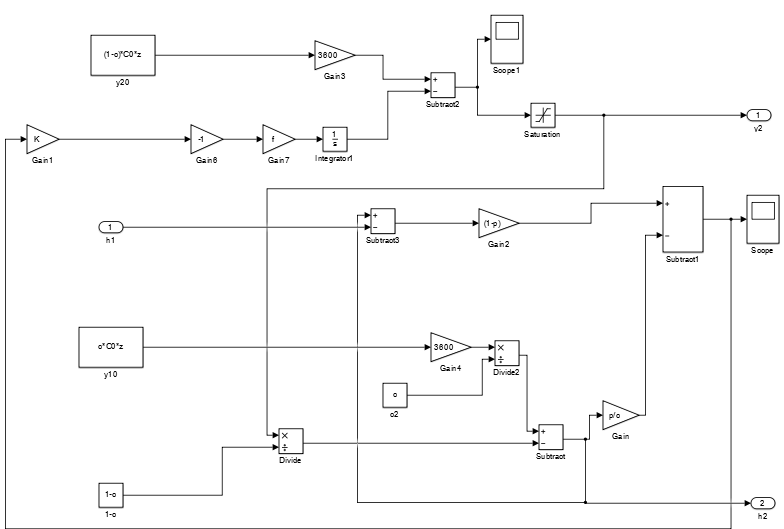
Figure 11. Simulink function to determine the variable 𝑦 1 in the kinetic battery model (KiBaM) modeling.